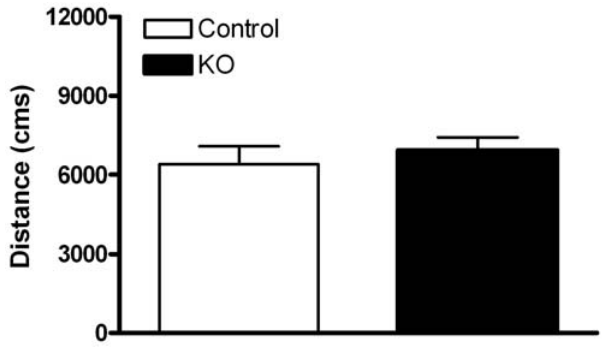
Figure 7. Exposure to a novel environment does not enhance locomotor activity in Pten KO mice. Control (n=11) and Pten KO (n=15) animals were placed in activity chambers to measure the locomotor response to a novel environment. No significant differences were found in all parameters measured during a cummulative period of 30 minutes. Total distances traveled is shown as a representative measure. All data are mean 6 SEM. *p , 0.05, Student’s t-test.